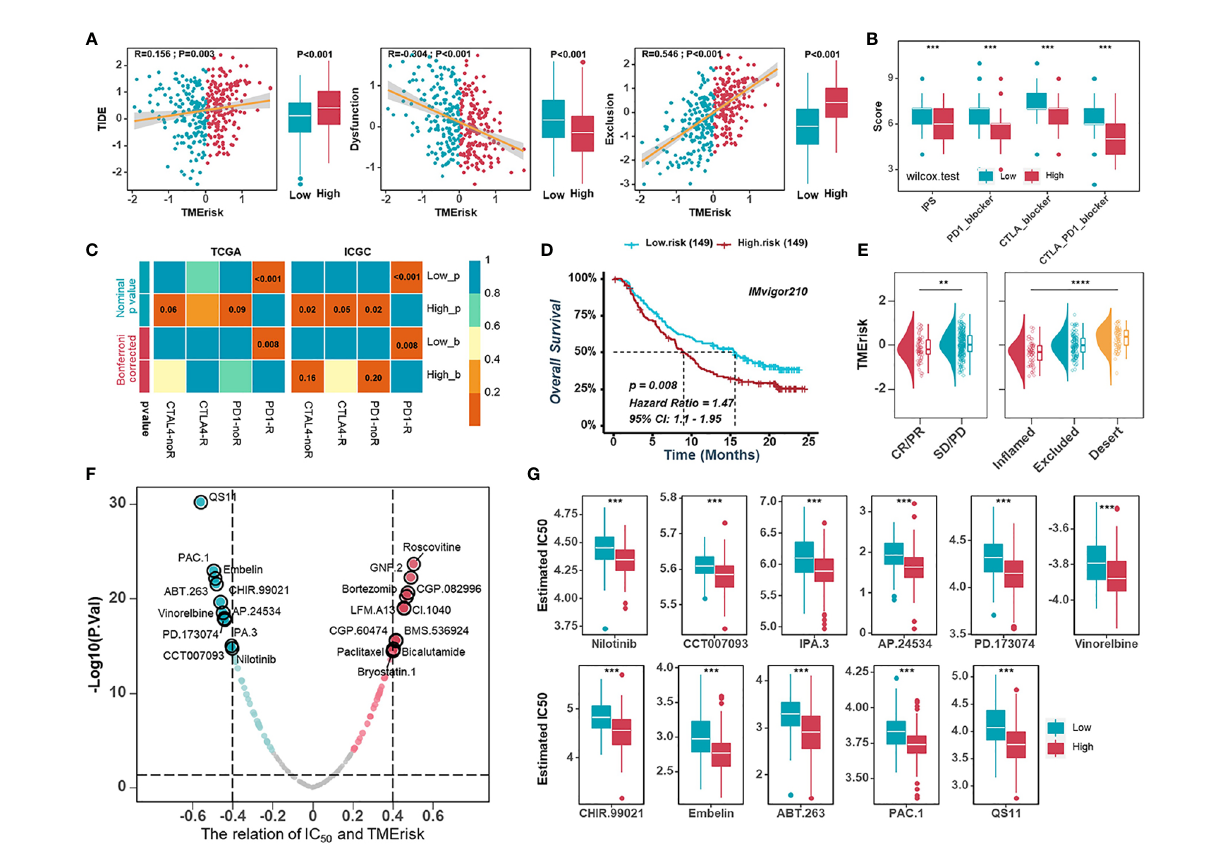
FIGURE 6 Predictive value of the TMErisk score in immunotherapy and chemotherapy. (A) The correlations between the TMErisk score with TIDE score (left), dysfunction score (middle), and exclusion score (right). (B) The correlation between the TMErisk score and IPS predictor. (C) Submap analyses predicting the probability of immunotherapy responses (anti-PD-1 and anti-CTLA-4) in low- and high-TMErisk groups, in TCGA-OV and ICGC cohort, respectively. (D) Kaplan-Meier analysis estimating the overall survival of low- and high-TMErisk groups in IMvigor210 cohort. (E) The distribution of TMErisk scores across groups with different immune response status (left) and immune phenotypes (right). (F) The relation between the IC 50 of candidate drugs and TMErisk scores. (G) Boxplots showing the estimated higher IC 50 values of drugs in the low-TMErisk group. ** P < 0.01; *** P < 0.001; **** P <